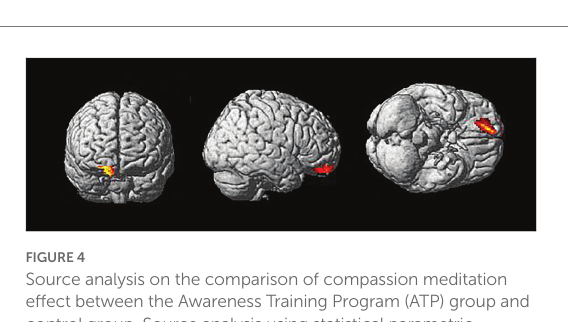
FIGURE 4 Source analysis on the comparison of compassion meditation effect between the Awareness Training Program (ATP) group and control group. Source analysis using statistical parametric mapping (SPM) indicated that the brain regions specifically activated by compassion meditation are located in the medial prefrontal